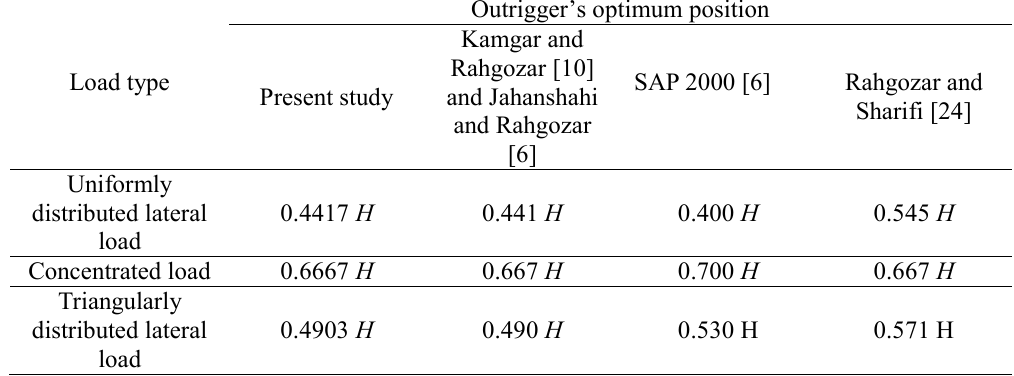
A comparison between the outrigger’s optimum position obtained by different